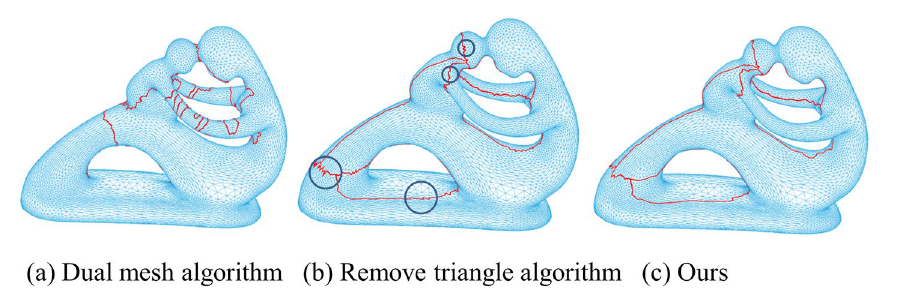
Figure 4. Three different cutting